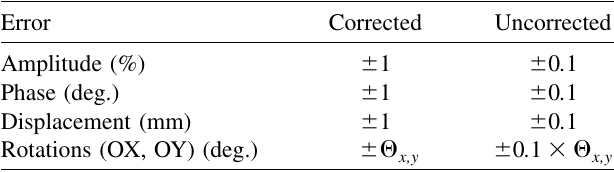
Rotations (OX, OY)